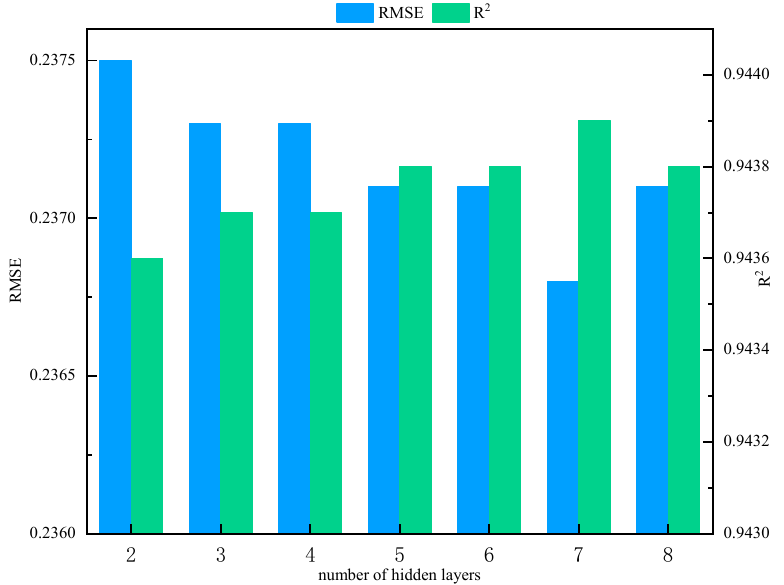
Figure 8. Prediction performance of DNN models with different numbers of hidden layers.